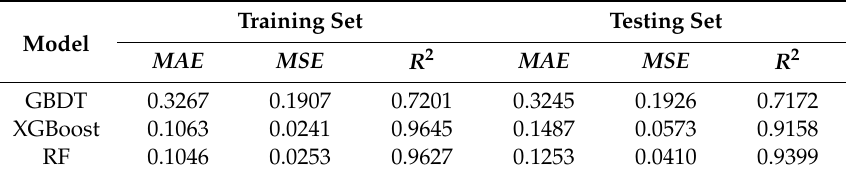
Table 3. Estimation models for fat content based on three algorithms.